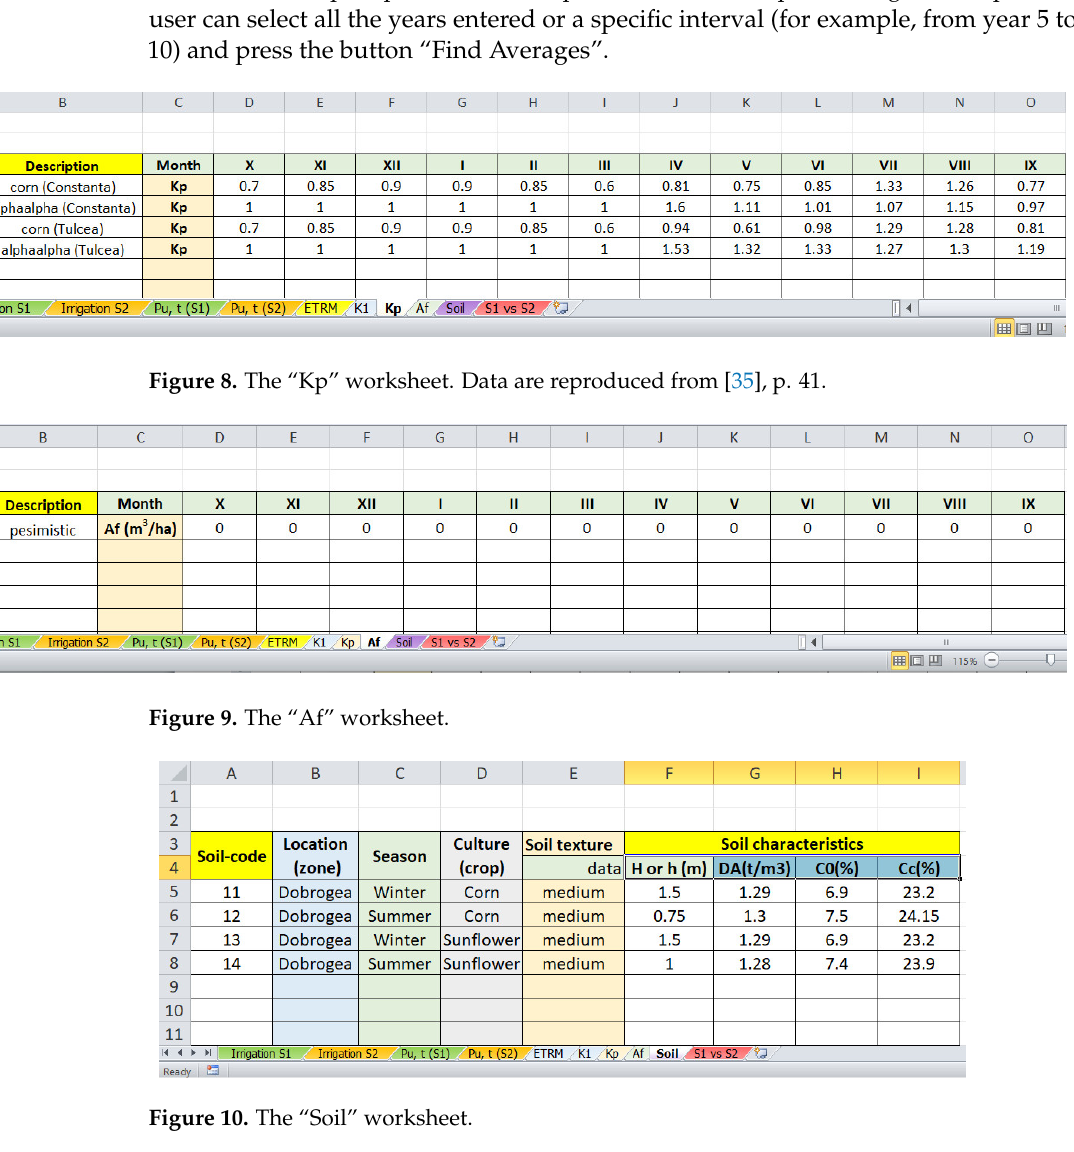
Figure 11. The “S1 vs. S2” worksheet. 5. Results In the following, we exemplify how IrrigTool works, giving as input the monthly temperature and precipitation at Constanța and Tulcea (Romania) for 22 agricultural years (1998–2019). Given that the agricultural year starts in October (1 or month X in all the charts), the data series are introduced in the “Pu, t (S1)” and “Pu, t (S2)” worksheets. The chosen crop was corn. Considering the geographical position of Romania, the K1 code represents the val- ues of K1 corresponding to 45° northern latitude (Figure 7—C10). The Kp code was chosen as 11 and 13 for CT and TL, respectively (Figure 8). The water supply from groundwater was   = 0 because the region is arid, so the Af code was set to 11 (Figure 9). The Soil code (Figure 10) for winter (summer) was the same, 11 (12), given the same soil characteristics. The ETRM code was set to “auto”, so the ETRM was computed using Equation (3). The initial water reserve in soil for October (Ri for month X) must be provided to start the computation. The user may introduce the value in the cell corresponding to “Ri for month X” from “Irrigation S1” and “Irrigation S2” or allow the software to compute it based on the formula (6) if “0” is inserted in that cell. The results obtained when the Ri for